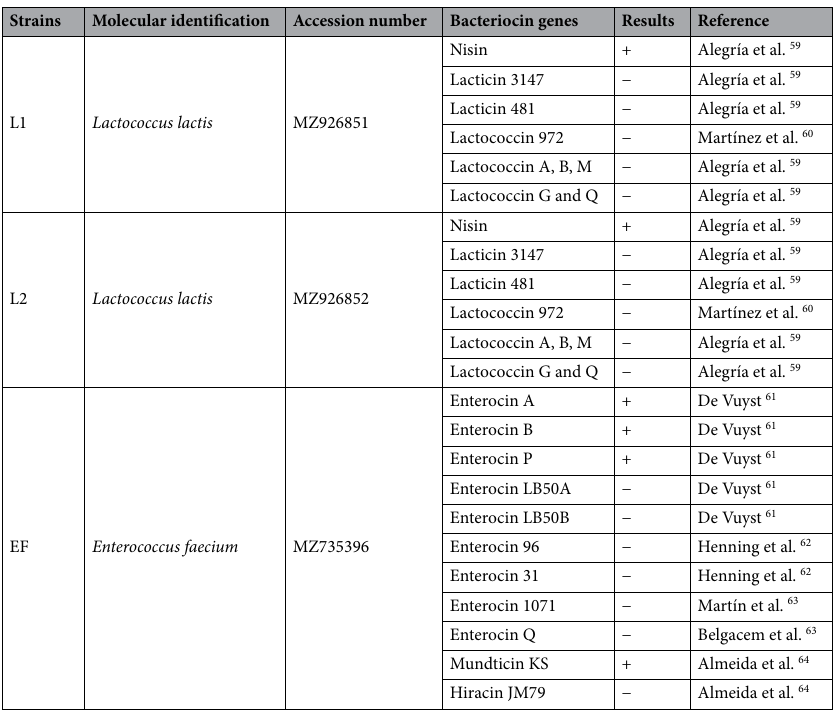
Table 1. Molecular identification (16S rRNA) and screening for presence of bacteriocin genes in L. lactis (L1 and L2) and E. faecium strains (EF). + target gene detected, − target gene not